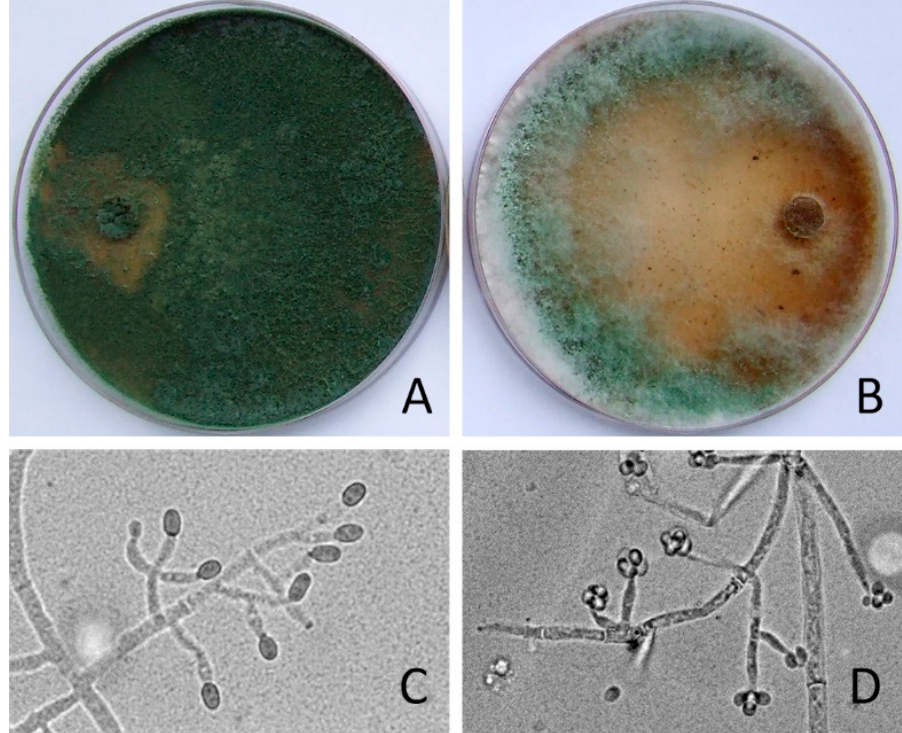
Figure 1. Macromorphology and micromorphology of Trichoderma strains on MEA after 7 days. ( A )— T. ghanense colony and ( C )—conidiophores and conidia. ( B )— T. tomentosum colony and ( D )—conidiophores and conidia. Magnification × 400.